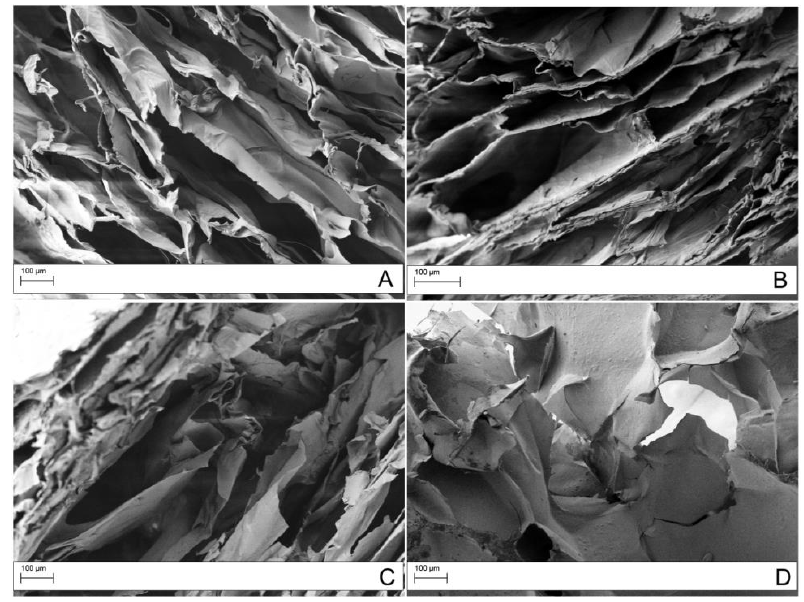
Figure 7. Field Emission Scanning Electron Microscope ( FESEM) micrographs of scaffolds obtained with 1% CS solution: ( A ) CS; ( B ) GO sigma /CS SL 1%; ( C ) GO exfoliated /CS SL 1%; ( D ) GO sigma /CS FD